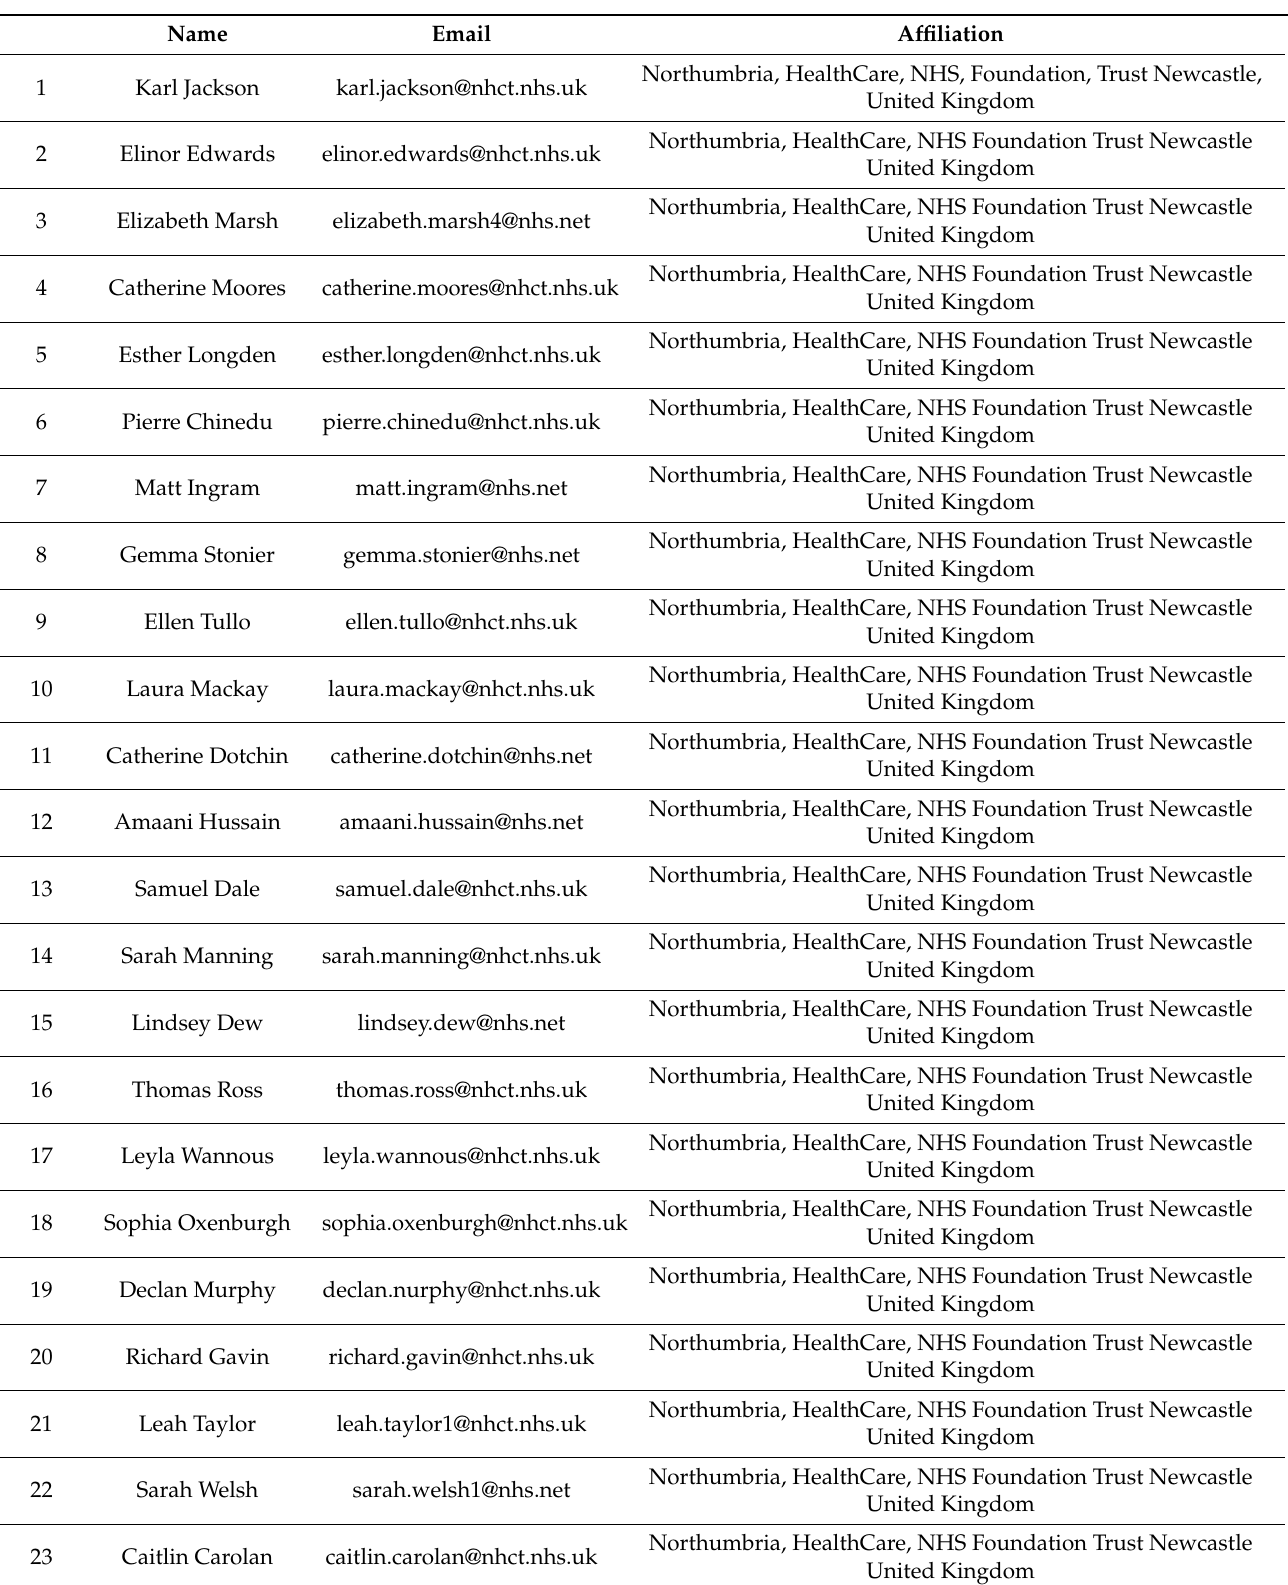
Table A1. Northumbria COVID-19 Audit